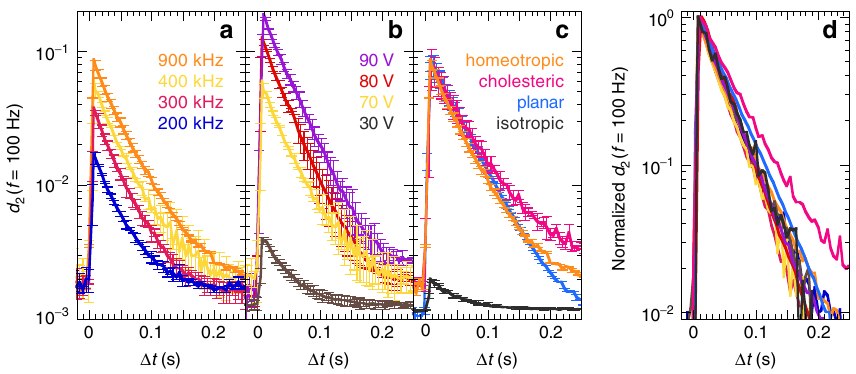
Fig. 5 Stage I: Dielectric response. Fast transient of nanoscale motility as the fi eld drives the polar mesogens into oscillation, whose amplitude depends on the fi eld frequency ( a ), voltage ( b ) and LC order ( c ). The error bars are de fi ned as s.d. of the fi eld-on/off average. Conditions: a homeotropic LCN at 70 V, b homeotropic LCN at 400 kHz and c 70 V and 900 kHz. d Superposition of all curves through normalization highlights the dynamic signature of this